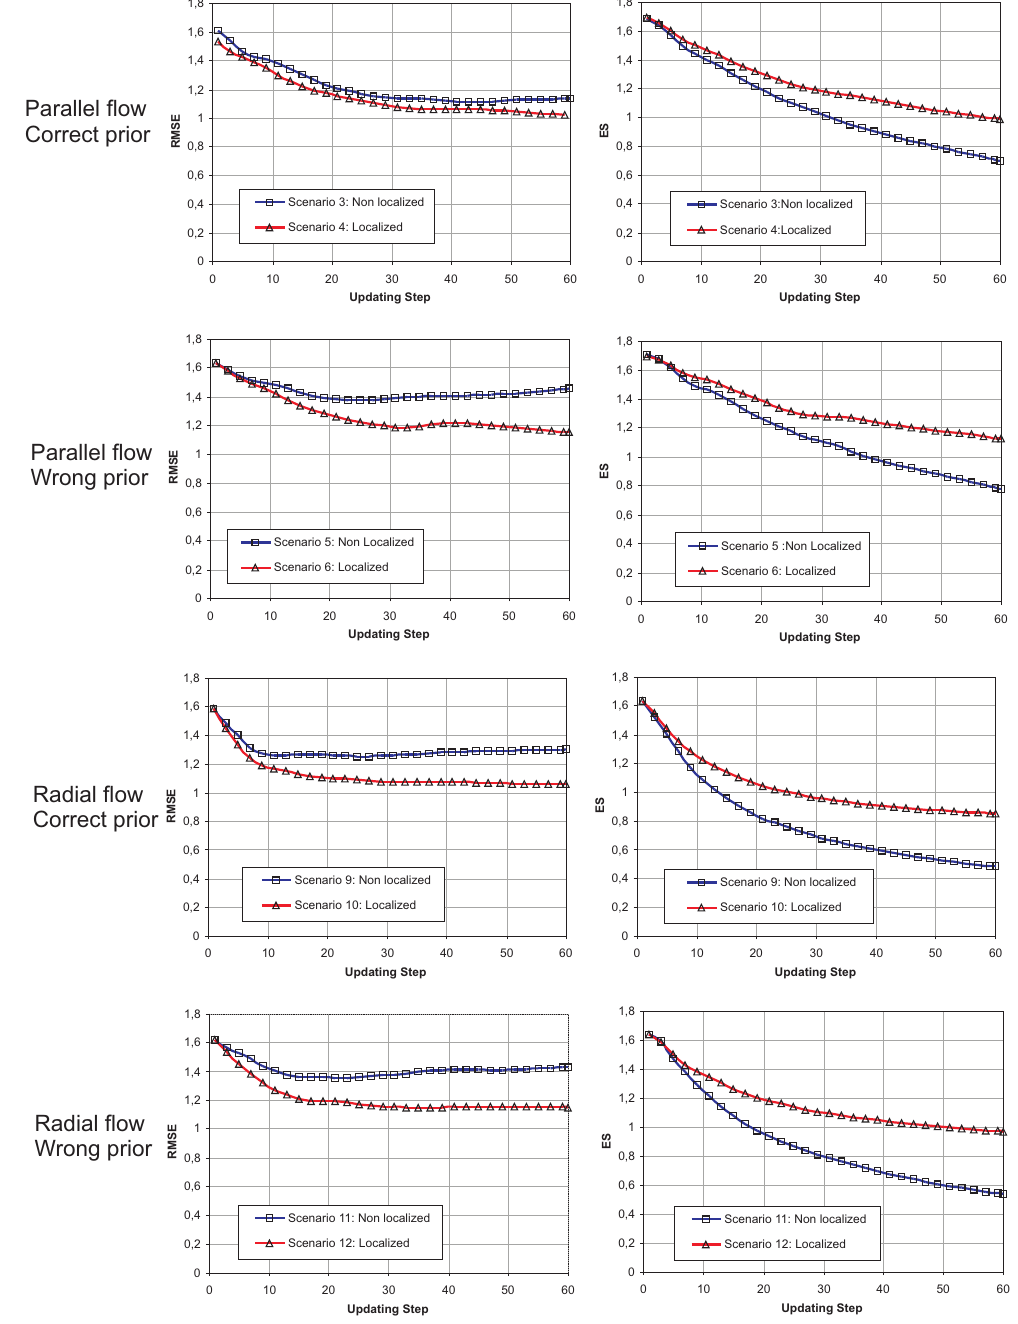
Fig. 7. RMSE and ES of ln K for the different cases. their prior random function models (see the first realization in Fig. 4a and